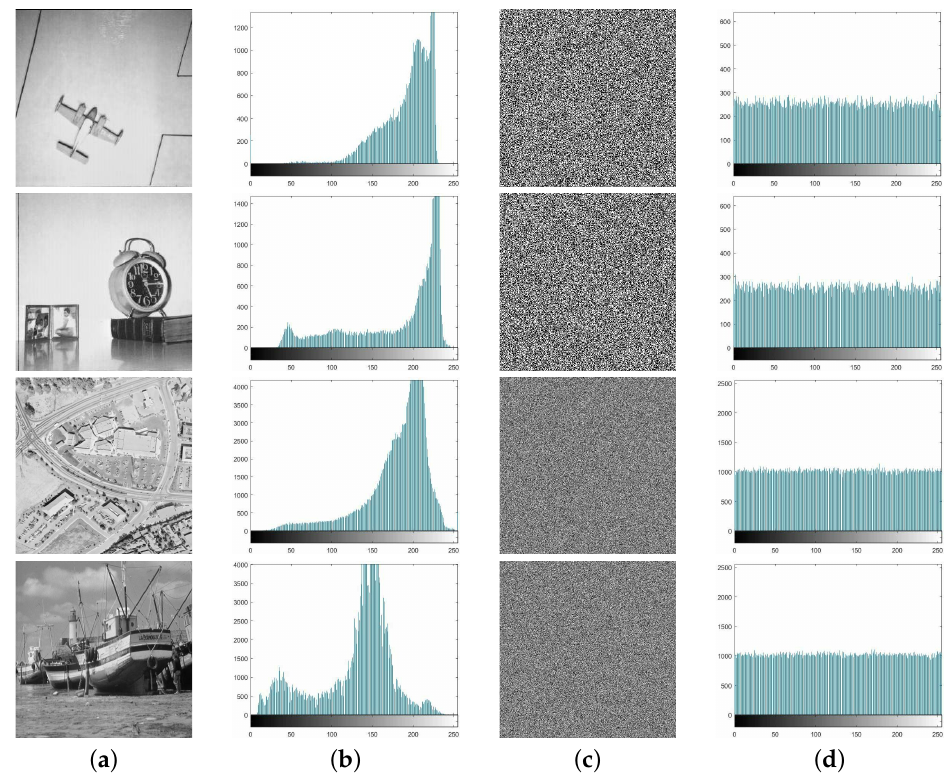
Figure 11. Histograms of plain images and corresponding cipher images: ( a ) plain images; ( b ) his- tograms of plain images; ( c ) cipher images; ( d ) histograms of cipher